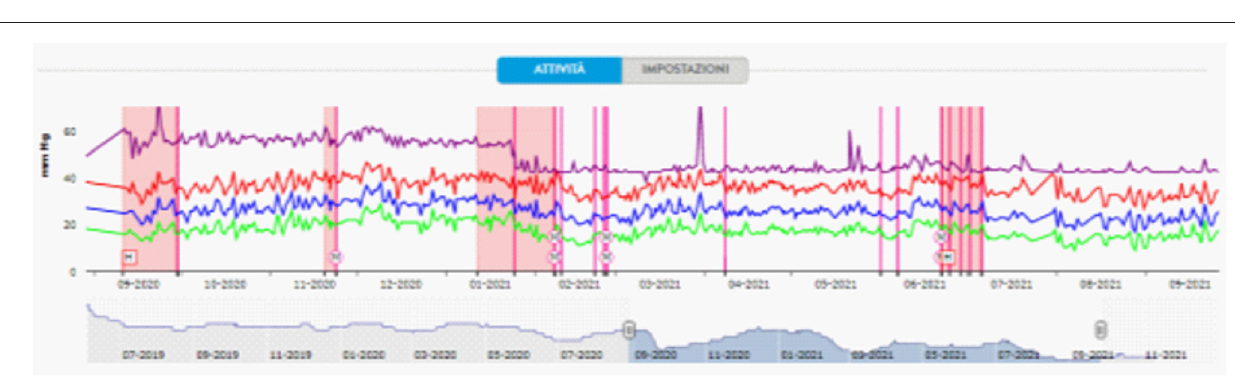
FIGURE 3 | A 12-lead ECG with visible spikes of high-energy impulses from CCM therapy.